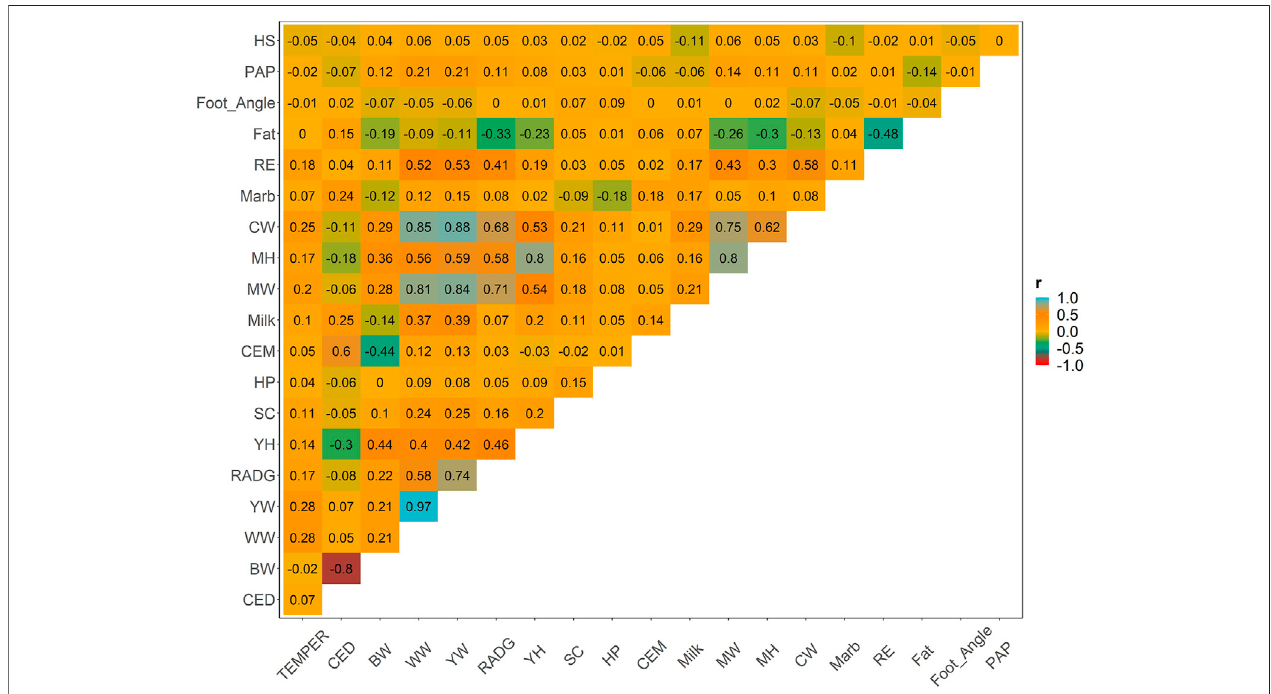
FIGURE 2 | Weighted Pearson correlation among all estimated breeding values for relevant traits in the beef cattle